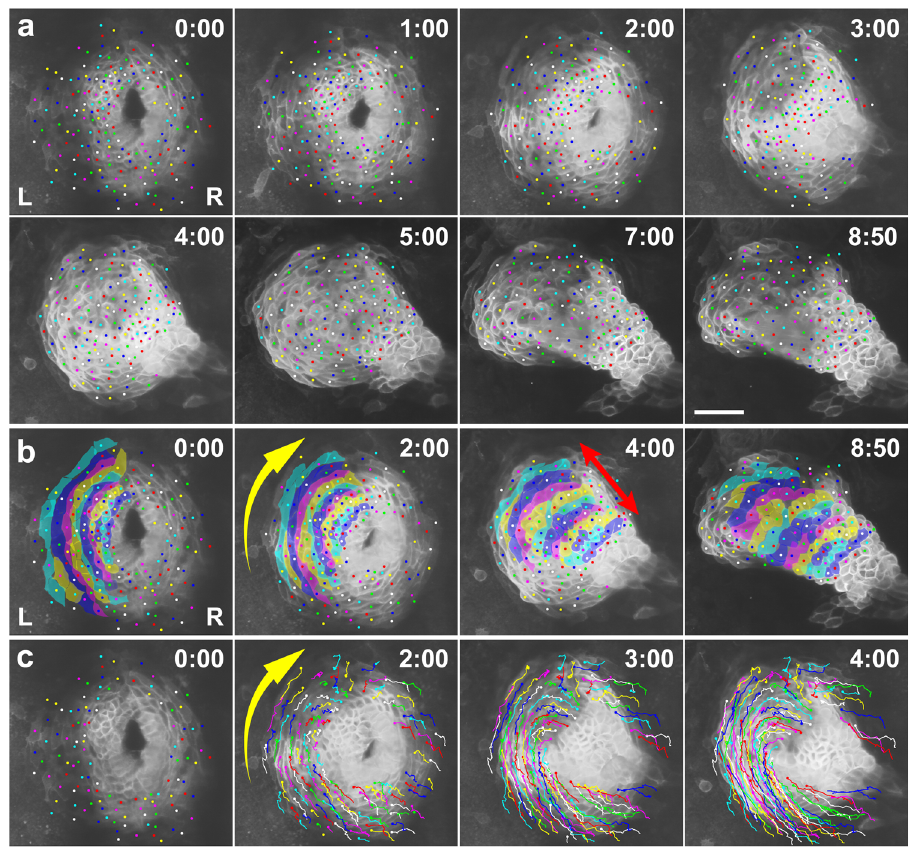
Fig. 2 The cardiac disc undergoes convergent extension. a Selected images from a confocal time-lapse recording of a Tg(myl7:EGFP-CAAX) ncv536Tg embryo starting at 20 hpf (Supplementary Movie 1). Cell membranes of myocardial cells are speci fi cally labeled with GFP in the transgenic line. Dorsal view (anterior to the top). Relative times after the initiation of the recording (h:min) are indicated in the upper right corner. Color dots indicate tracking of individual myocardial cells. Images are representative of n ≥ 10 embryos. Scale bar = 50 µ m. b Annotated duplicate images. Cells in the left primordium are colored. The group of cells converged in the circumferential direction toward the anterior seam of the left (L) and right (R) primordia (yellow arrow in b ), while extending perpendicularly (red arrow in b ) as the disc transformed into a tube. c Duplicated images overlaid with cell trajectories. Cell rearrangement and cell shortening occurred circumferentially toward the anterior seam of the left and right primordia (yellow arrow in c